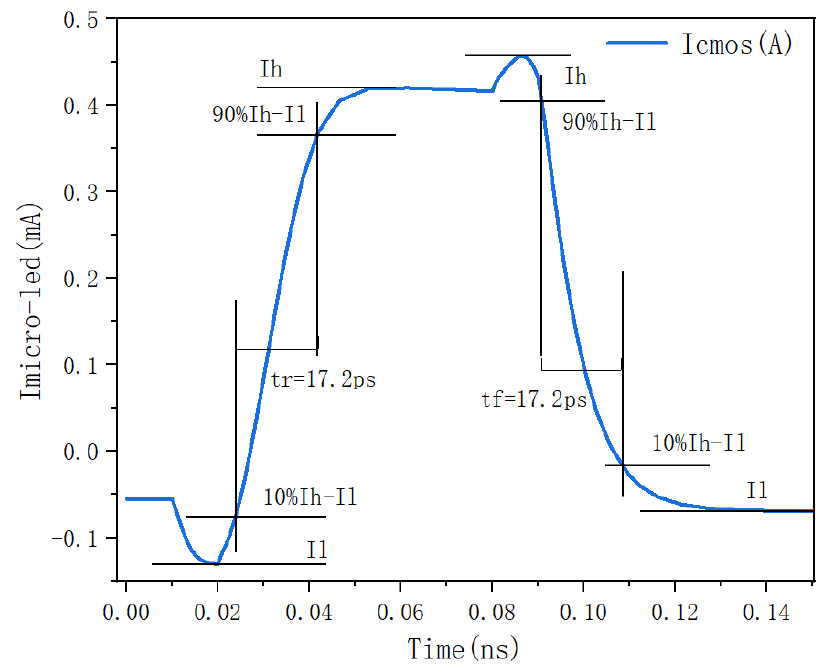
Figure 18. Analysis of rising time and falling time of the output current curve of the micro-LED driven by the CMOS inverter, connected with a current limiting resistor with time.